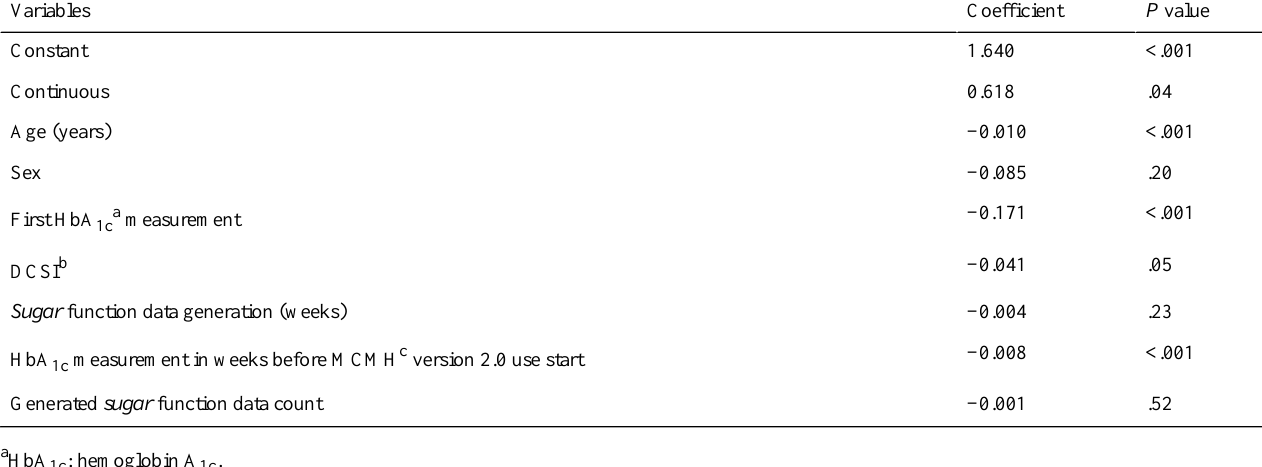
Table 4. The result of logistic regression against users with a high first hemoglobin A 1c measurement (n=111 continuous and n=5716 noncontinuous